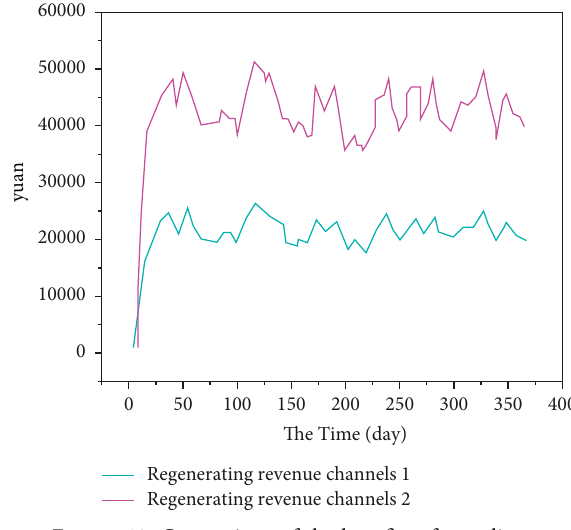
Figure 10: Environmental tariff.